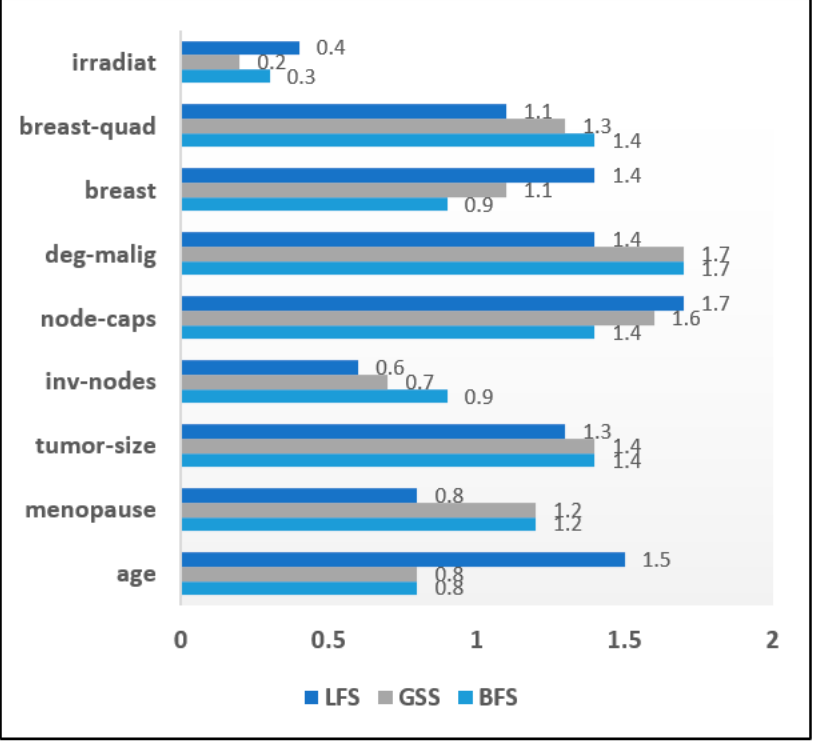
Appl. Sci. 2020 , 10 , x FOR PEER REVIEW Figure 10. Attribute Significance Graph for the Diabetes dataset with Wrappers.